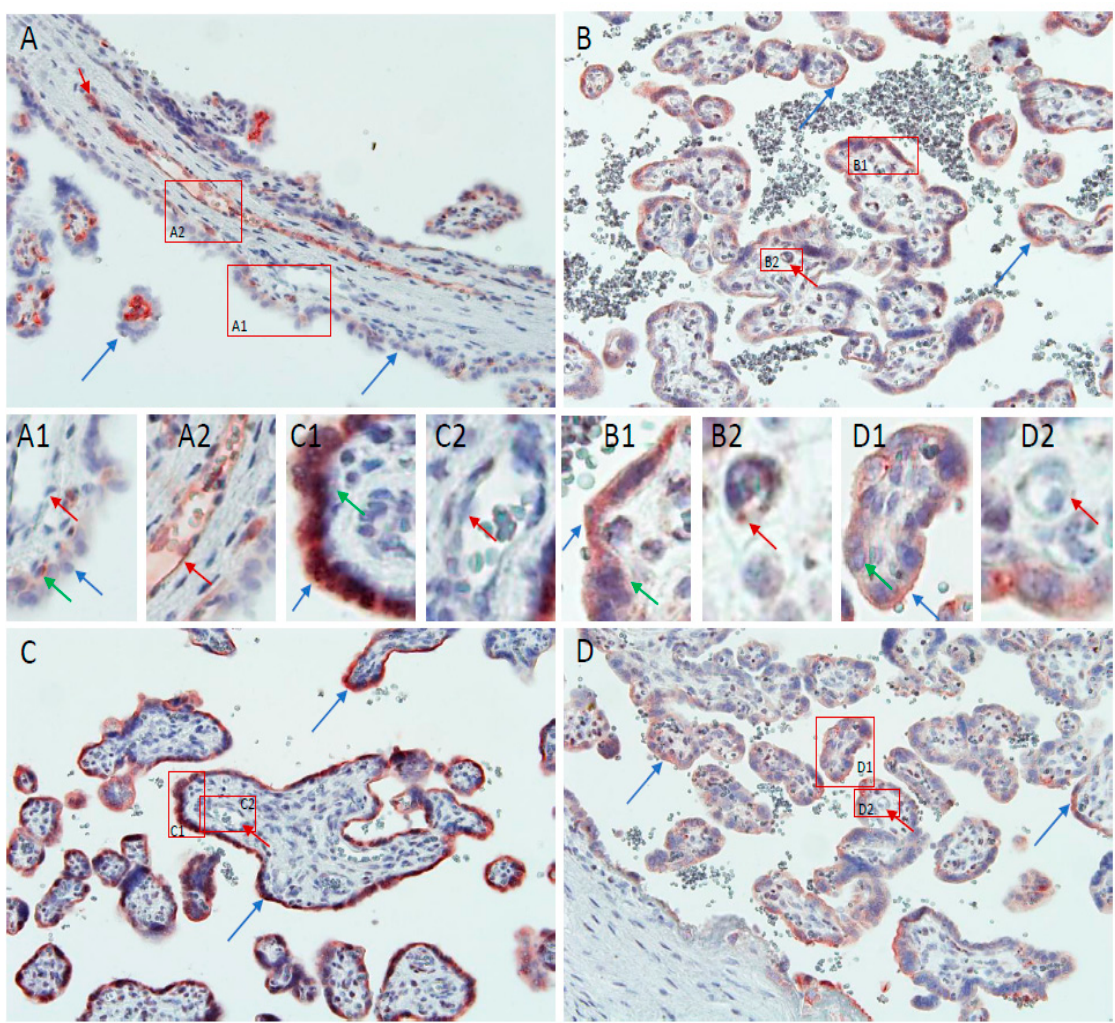
Figure 3. Immunohistochemical staining for CD24 in placental tissues. ( A ) early PE; ( B ) preterm delivery; ( C ) late PE; ( D ) term control. Blue arrows point to villous syncytiotrophoblast, green arrows point to villous cytotrophoblasts, and red arrows to villous blood vessels. Original magnification of A to D × 200. The small images are higher magnifications from the four larger images to better show staining of villous syncytiotrophoblast and cytotrophoblast ( A 1– D 1), as well as villous blood vessels ( A 2– D 2).